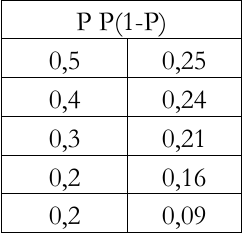
Figure 1. Lemeshow Rumus